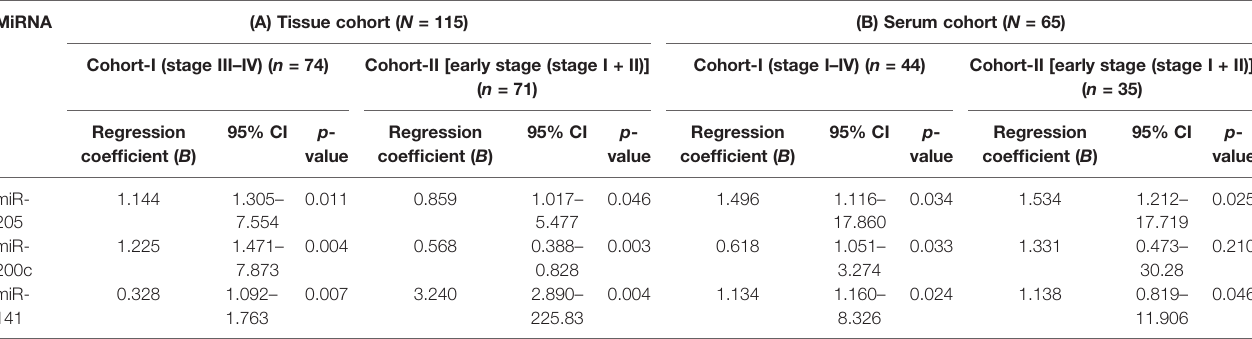
TABLE 2 | Binary logistic regression analysis of tissue {cohort-I [including 44 advance-stage tissue sample (stage III – IV) + 30 normal samples; n = 74], cohort-II (including 41 early stage tissue samples + 30 normal samples; n = 71)} and serum samples [cohort-I (30 advance-stage III – IV samples + 14 normal samples) ( n = 44), cohort-II (21 early stage serum samples + 14 normal samples; n = 35)].